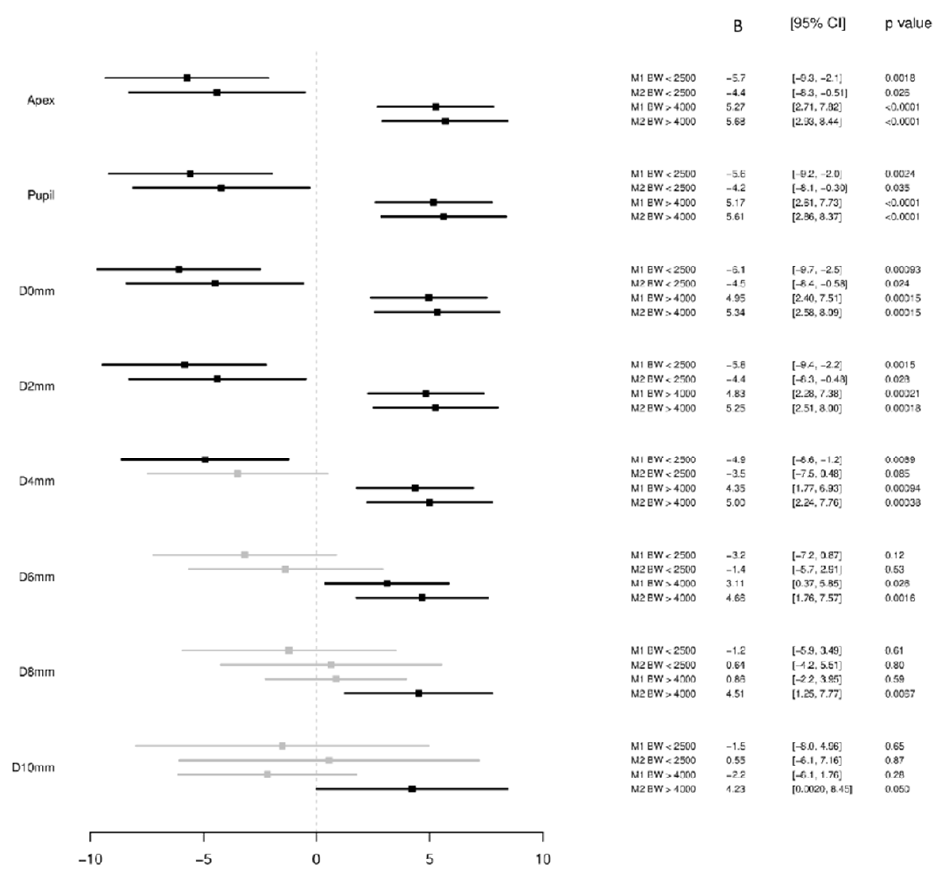
Figure 3. Associations of corneal thickness in the different corneal regions with Birth Weight Groups (low birth weight n = 315; normal birth weight n = 4655; high birth weight n = 687) in the Gutenberg Health Study (2012–2017). B—Beta; CI—Confidence interval. Linear regression analysis using generalized estimating equations to control for correlations between